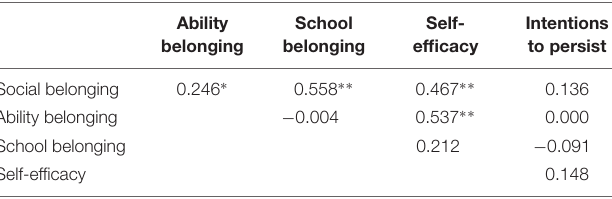
TABLE 3 | Intercorrelations among belonging, efficacy, and intentions to persist in pSTEM for male subjects.